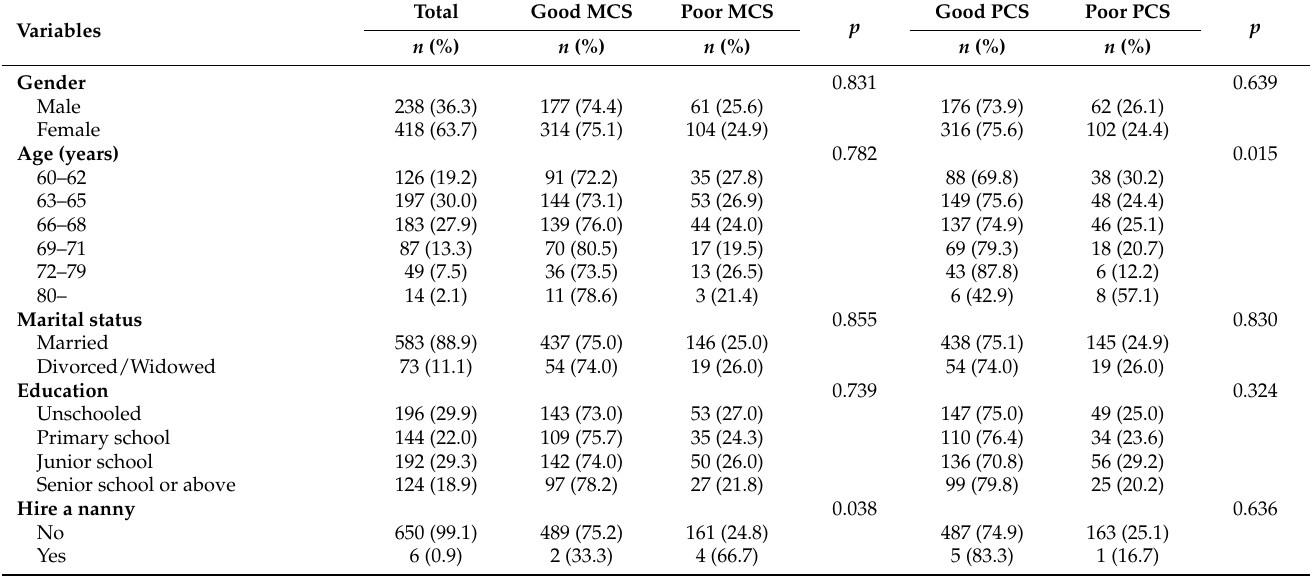
Table 1. Univariate analyses for HRQOL of MEFC in the mental and physical dimensions. Variables